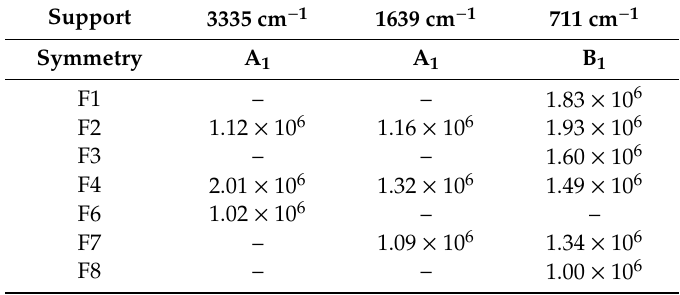
Table 3. Registered enhancement factors for the main bands of the FTIR spectrum of